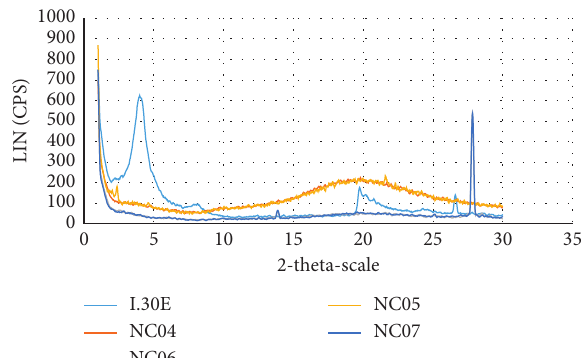
Figure 7: XRD diagram of materials I.30 E , MWCNTs/nanoclay/epoxy ( NC04 ), MWCNTs/nanoclay/ELO/epoxy ( NC06 ), MWCNTs/ nanoclay/Sb 2 O 3 /chlorinated paraffin/epoxy ( NC05 ), and MWCNTs/nanoclay/ELO/Sb 2 O 3 /chlorinated paraffin/epoxy ( NC07